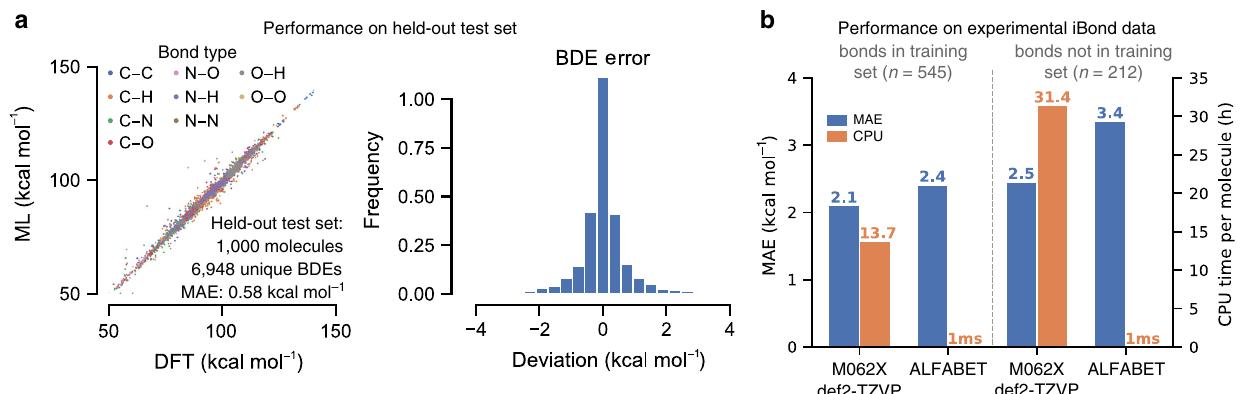
Fig. 3 Performance of the ML BDE prediction algorithm. a Performance on the held-out, DFT-generated test set. (left) Parity plot of ALFABET predictions vs DFT calculations. BDE points are colored by their bond type. (right) Histogram of prediction errors. The model achieves an MAE of 0.58 kcal mol − 1 relative to DFT-calculated values of unseen molecules. b Performance of the model on experimentally measured BDEs from the iBond database. Prediction accuracy was quanti fi ed separately for bonds inside the training database (left) and those outside it (right). Molecules and bonds outside the training set tended to be much larger, thus resulting in larger DFT error and long DFT computational times.